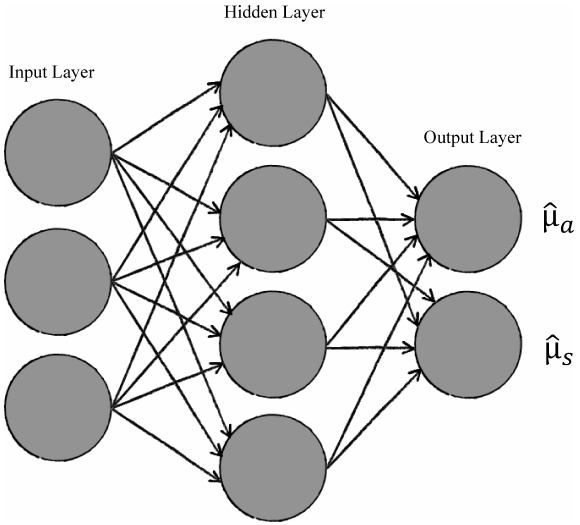
Fig. 6. ANN structure for the estimation of (cid:1) a and (cid:1) s .